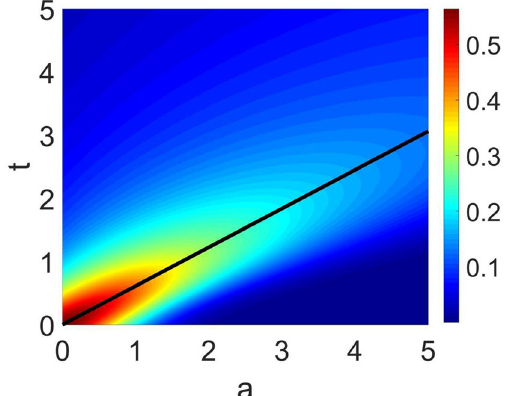
Fig. 16 Evolution of the probability distribution of the scale factor. The horizontal axis represents the scale factor, and the vertical axis represents the time variable. The black curve is the classical trajectory of the universe. The parameters are taken as: p a = 1, α = 1, V 0 = π